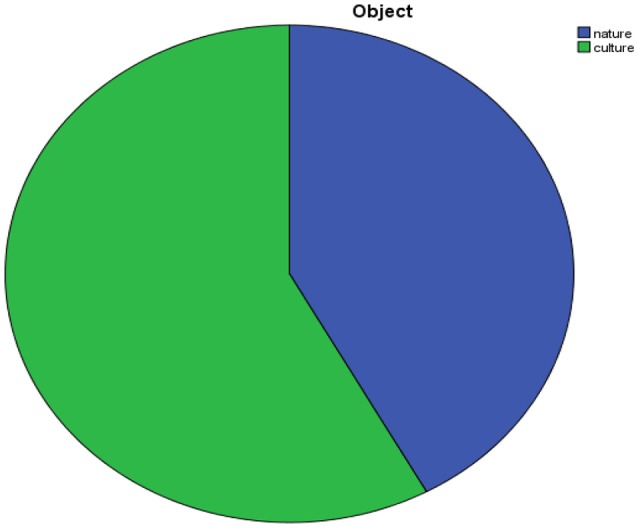
Object of discourse.